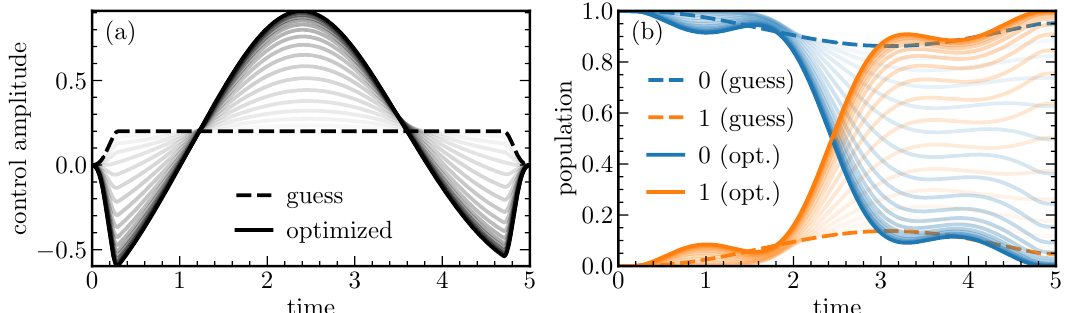
Figure 1: (Color online) Control fields and population dynamics for each iteration of the optimization procedure. (a) The initial guess control (dashed black line) and optimized controls (solid lines), with increasing opacity for each iteration of the op- timization. The solid black line is the final optimized control. (b) The population dynamics for the two levels | 0 〉 (blue) and | 1 〉 (orange). The dynamics under the guess control are indicated by the dashed lines, and the dynamics under the opti- mized control of each iteration by the solid lines, with the opacity increasing with the iteration number. All quantities are in dimensionless